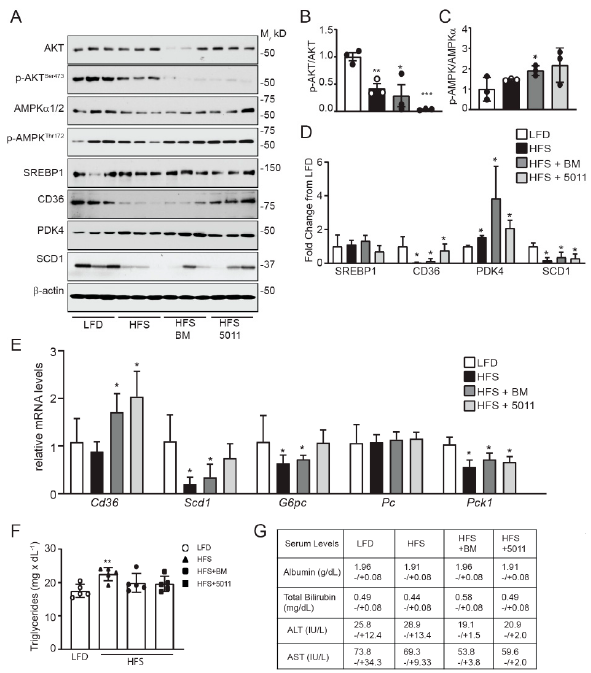
Figure 5. Hepatic markers of insulin responsiveness and lipid metabolism are altered by the HFS diets in female mice. Protein and gene expression were assayed in liver by Western blotting ( A ) and RT-PCR ( E ). Western blot density quantification is depicted for AKT activation ( B ), AMPK α activation ( C ) and fold change of lipid metabolism protein markers ( D ). Western blot analysis indicates that insulin responsiveness was diminished in livers of HFS-fed mice, with botanical supplementation intensifying this e ff ect ( B ), as indicated by reduced AKT phosphorylation. Panel ( C ) shows increased activation